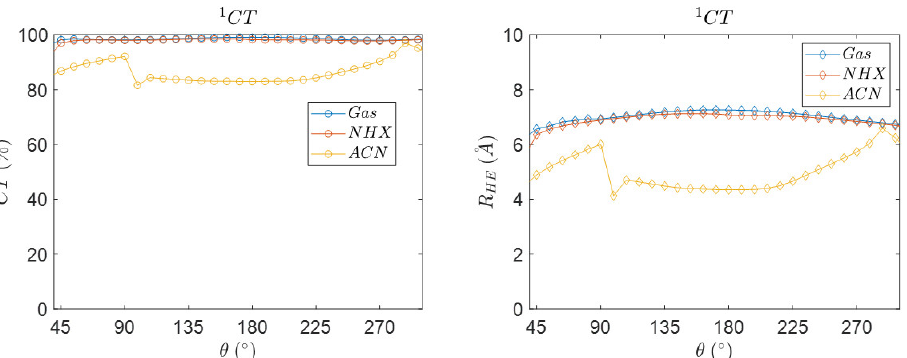
Figure 12. The conformational dependence of the charge transfer character. Charge transfer descriptors for the 1 CT singlet charge transfer state calculated starting with the S 1 geometry. The descriptors are calculated as function of the dihedral angle at the optimized singlet charge transfer state S 1 in different solvents. Geometries are calculated with PBE and TZP. The quantities are calculated with the TZP basis and the CAMY-B3LYP functional.